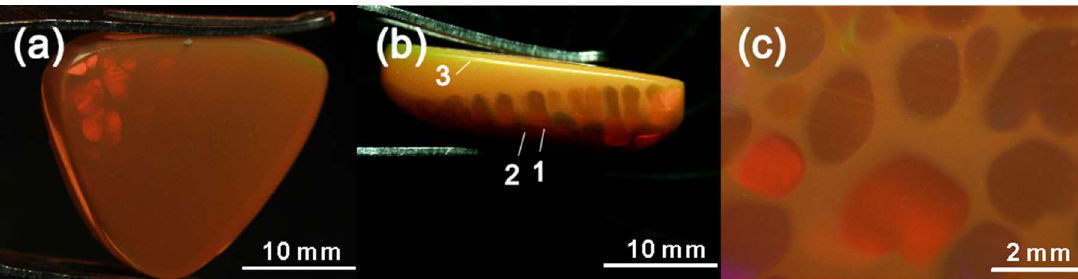
Figure 3. Opal-02 showing the characteristic digit pattern. Columns (1) are transparent with a vivid play-of-colour, separated by common opal matrix (2); ( a ) The top of the sample is covered by common opal (3); ( b ) When viewed from the perpendicular direction, the surface shows a finger-light structure. Transparent areas are the vertical sections of parallel columns and rounded at one end; ( c ) When viewed from the bottom of the sample, the surface shows a mosaic pattern. The transparent rounded patches are cross sections of columns, separated by an opaque matrix composed of common opal [23].